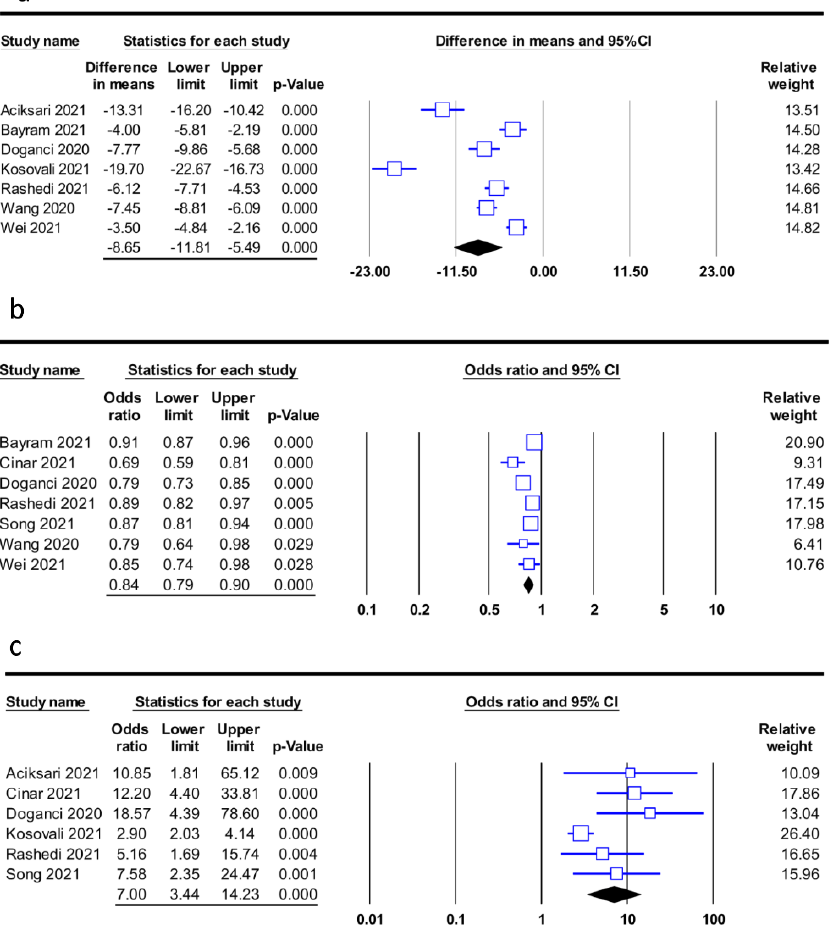
Figure 3. ( a ) Forest plot comparing the prognostic nutritional index (PNI) between mortality and non-mortality groups, showing a lower mean PNI in the mortality group compared to the non-mortality group (MD: − 8.65, 95% CI: − 11.81 to − 5.49, p < 0.001, I 2 = 95.3%) [19,21,28,29,32,34,36], ( b ) Forest plot demonstrating a negative correlation between risk of mortality and PNI as a continuous parameter (odds ratio: 0.84, 95% CI: 0.79 to 0.9, p < 0.001, I 2 = 67.3%) [11,19–21,29,34,36], and ( c ) Forest plot showing a negative association between risk of mortality and PNI as a binary parameter (odds ratio: 7, 95% CI: 3.44 to 14.23, p < 0.001, I 2 = 65.7%) [11,20,28,29,32,36]. CI, confidence interval.